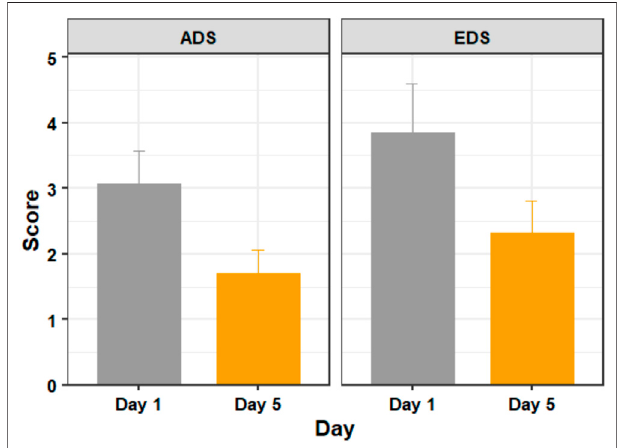
FIGURE 3 | The average discomfort score (ADS) and ending discomfort score (EDS) of participants on days 1 (before training) and 5 (after training). Figure shows mean and standard error.